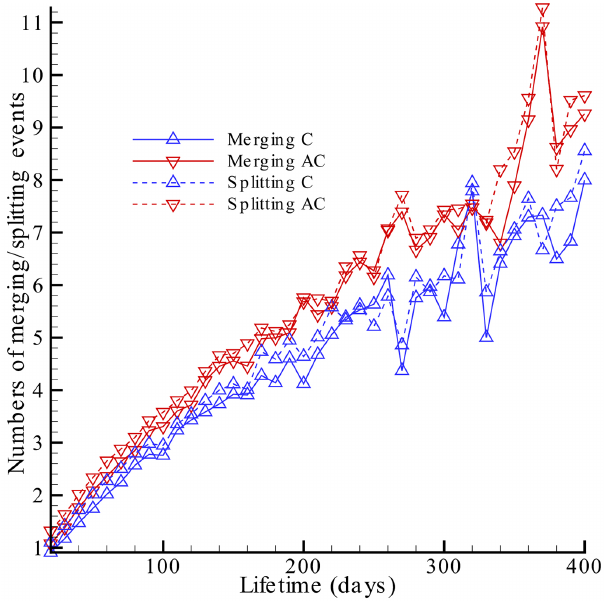
Figure 13. The number of merging/splitting events per eddy as a function of eddy lifetime, where AC and C represent anticyclonic and cyclonic eddies.